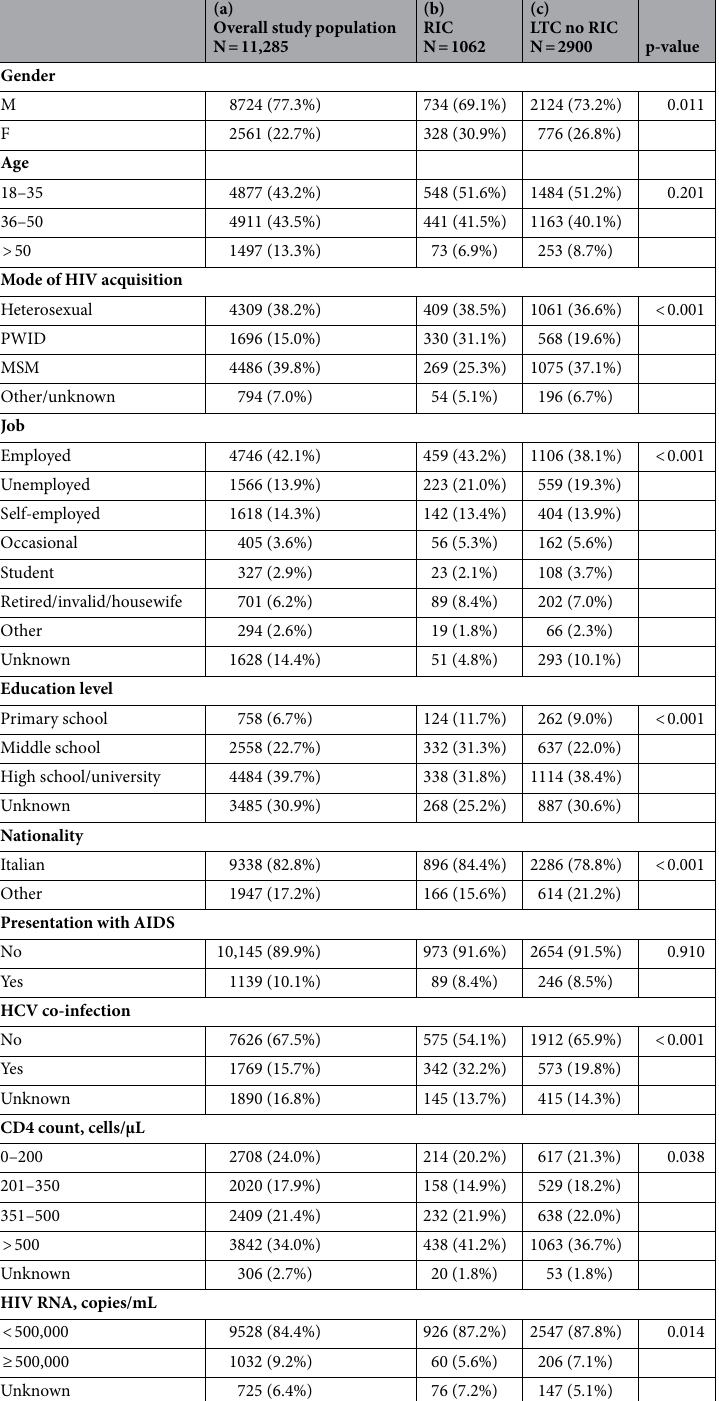
Table 1. Main characteristics at the enrolment of the study population (a) and of the RIC patients (b) compared with LTC not returning to the care